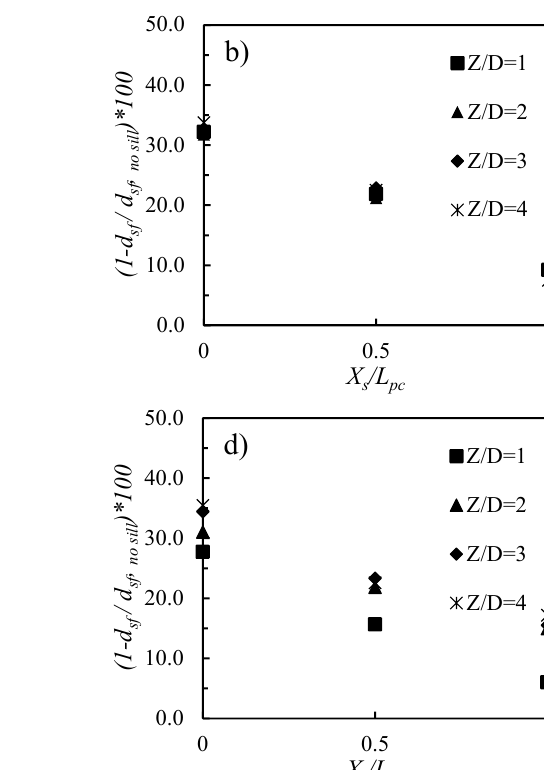
Figure 8. Comparison of maximum scour depth in conditions with and without sill for T pc /D = 0.85 , d p /D = 0.57, ( a ) m = 2, ( b ) m = 3 and T pc /D = 1.42, d p /D = 0.57, ( c ) m = 2, ( d ) m = 3.